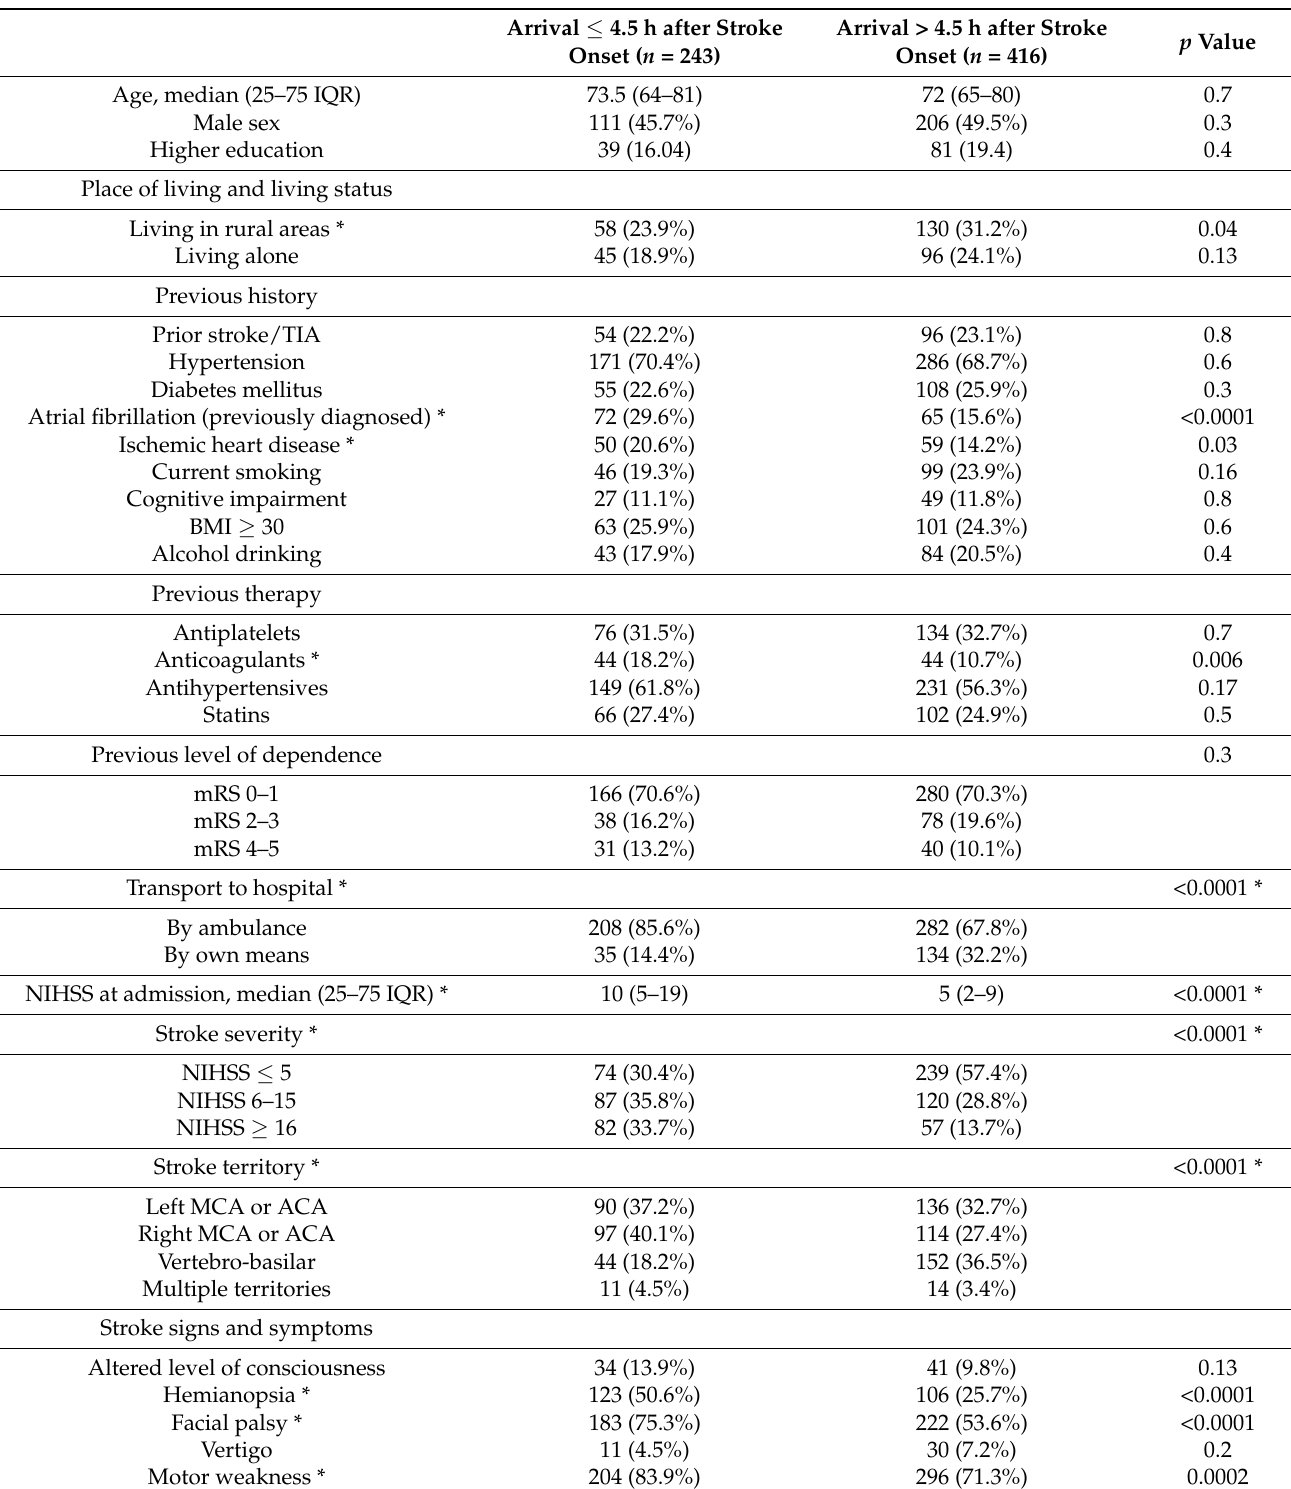
Table 1. Baseline characteristics of patients arriving at hospital before and after 4.5 h from stroke